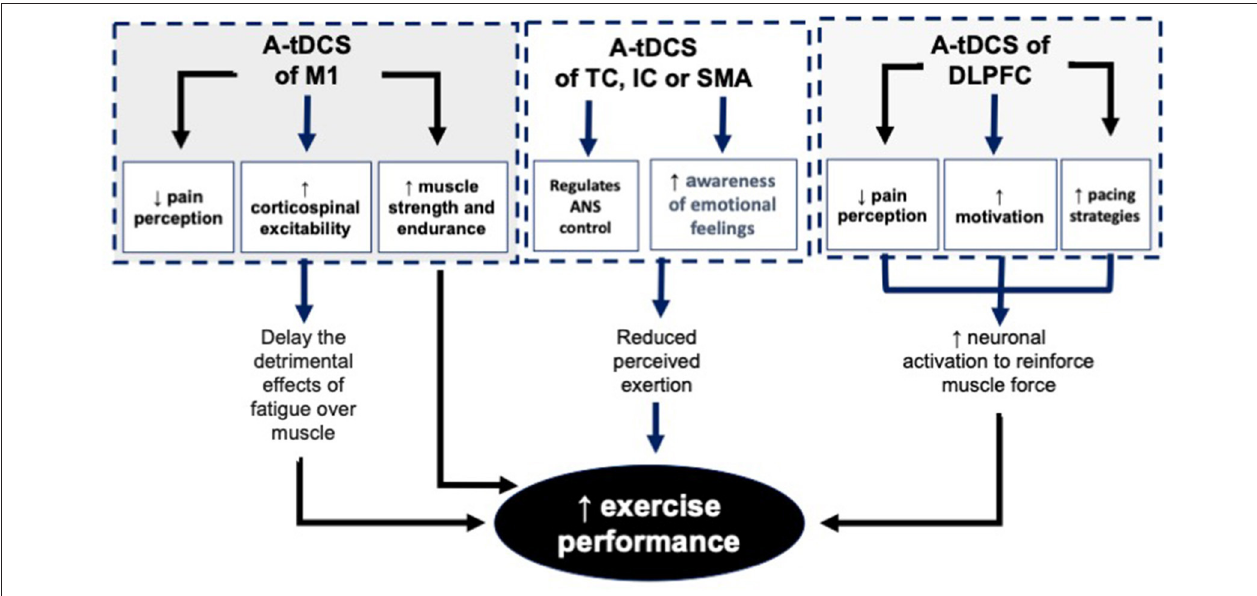
FIGURE 3 | The mechanisms behind the effects of A-tDCS of M1, TC, IC, SMA and DLPFC on EP. A-tDCS, Anodal transcranial direct current stimulation; M1, Primary motor cortex; TC, Temporal cortex; IC, Insular cortex; SMA, Supplementary motor area; DLPFC,